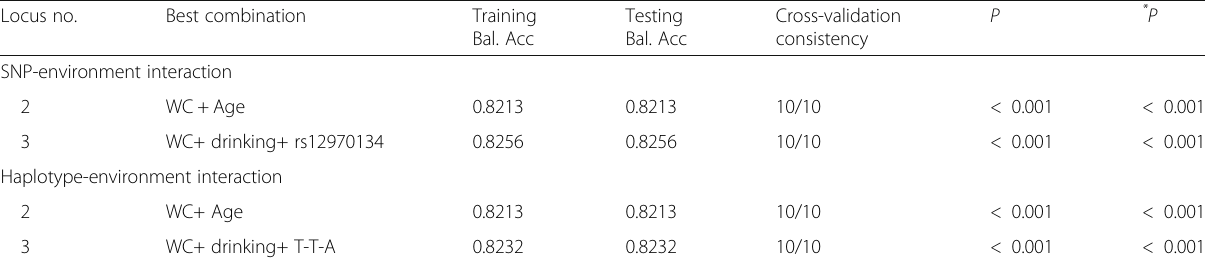
Table 5 GMDR analysis of SNPs, haplotype and environment showed different interactions Locus no. Best combination Training Bal.